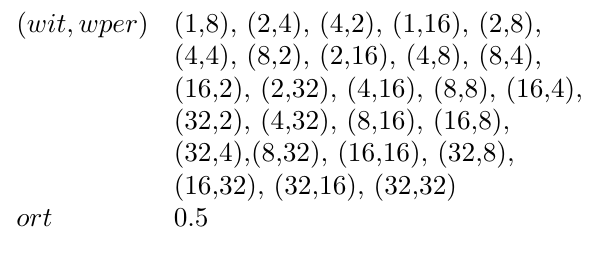
Table 1. Parameters of the